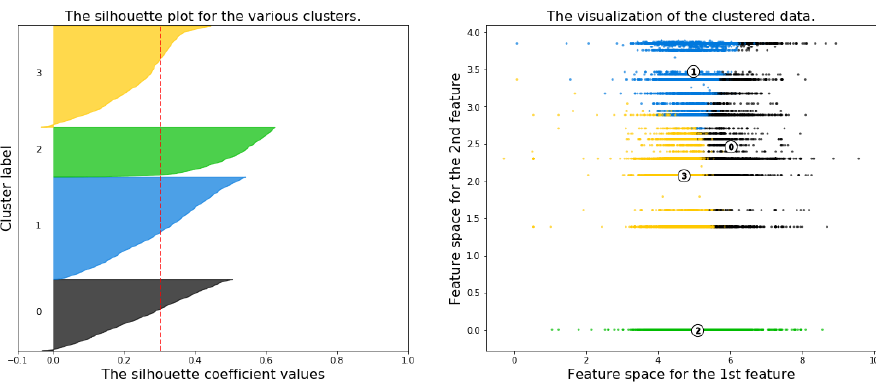
Figure 15. Silhouette analysis where the number of clusters is 4.